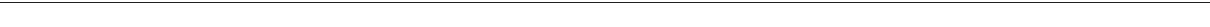
Fig. 1 Overview of RT-RamDA and single-cell RamDA-seq. a Schematic diagram of RT-RamDA. 1. RT primers (oligo-dT and not-so-random primers) anneal to a RNA template. 2. Complementary DNA (cDNA) is synthesized by the RNA-dependent DNA polymerase activity of RNase H minus reverse transcriptase (RTase). 3. Endonuclease (DNase I) selectively nicks the cDNA of the RNA:cDNA hybrid strand. 4. The 3 ′ cDNA strand is displaced by the strand displacement activity of RTase mediated by the T4 gene 32 protein (gp32), starting from the nick randomly introduced by DNase I. cDNA is ampli fi ed as a displaced strand and protected by gp32 from DNase I. b Relative yield of cDNA molecules using RT-qPCR ( n = 4). Mouse ESC total RNA (10 pg) was used as a template, and 1/10 the amount of cDNA was used for qPCR. The relative yield was calculated by averaging the ampli fi cation ef fi ciency of four mESC ( Nanog , Pou5f1 , Zfp42 , and Sox2 ) and three housekeeping ( Gnb2l1 , Atp5a1 , and Tubb5 ) genes using a conventional method ( − ) as a standard. c Schematic diagram of RamDA-seq and C1-RamDA-seq. For details, please refer to the Methods section. d Number of detected transcripts with twofold or lower expression changes against rdRNA-seq (count ≥ 10). For the boxplots in b and d , the center line, and lower and upper bounds of each box represent the median, and fi rst and third quartiles, respectively. The lower (upper) whisker extends to smallest (largest) values no further than 1.5 × interquartile range (IQR) from the fi rst (third) quartile. e Squared coef fi cient of variation of the read count. All conditions were adjusted, and 10 million reads were used in d and e . Transcripts were annotated by GENCODE gene annotation